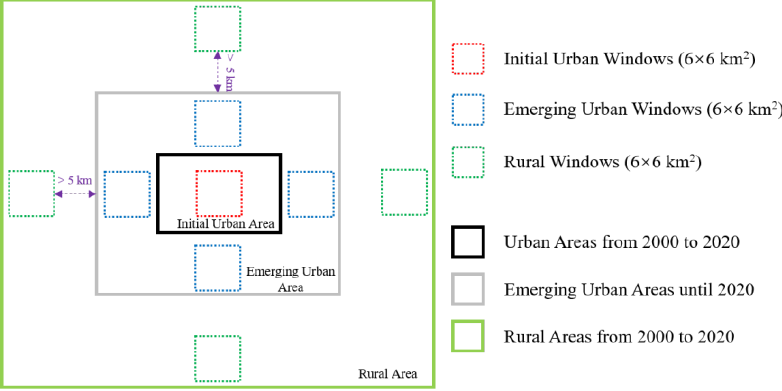
Figure 2. Schematic diagram showing the spatial distribution of the research windows for a given